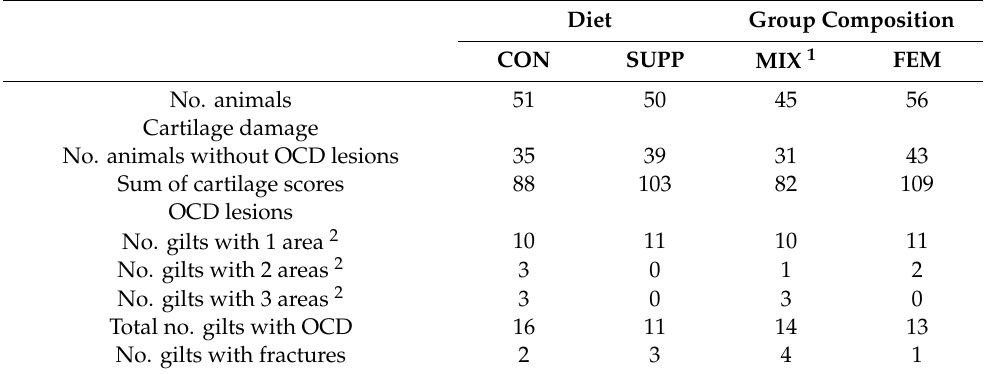
Table 4. Cartilage damage and OCD presence in the joints of gilts reared in either mixed sex (MIX) or female-only (FEM) groups and on a standard finisher diet (CON) or on a CON diet supplemented with minerals